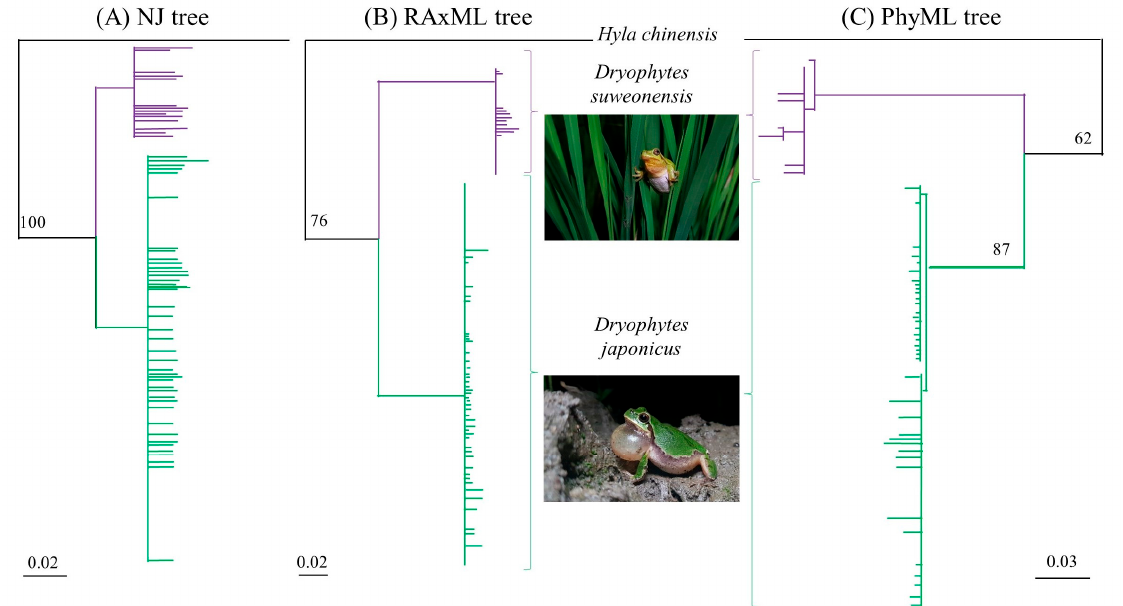
Figure 3. Mitochondrial phylogenetic trees inferred using (A) neighbour joining and maximum likelihood using (B) RAxML and (C) PhyML. All trees are built with Hyla chinensis (GenBank accession number AY458593.1) as outgroup. All trees are congruent, with the exception of a subclade within the PhyML tree as the only di ff erence. All trees were built in Geneious (v 9.04, Biomatters Limited, Auckland, New Zealand) with corresponding plug-ins, and all nodes below 30% support were collapsed. Purple represents Dryophytes suweonensis and green represents Dryophytes japonicus . *Denotes the presence of at least one individual in cytonuclear disequilibrium / hybrid for the individual or collapsed clade highlighted.